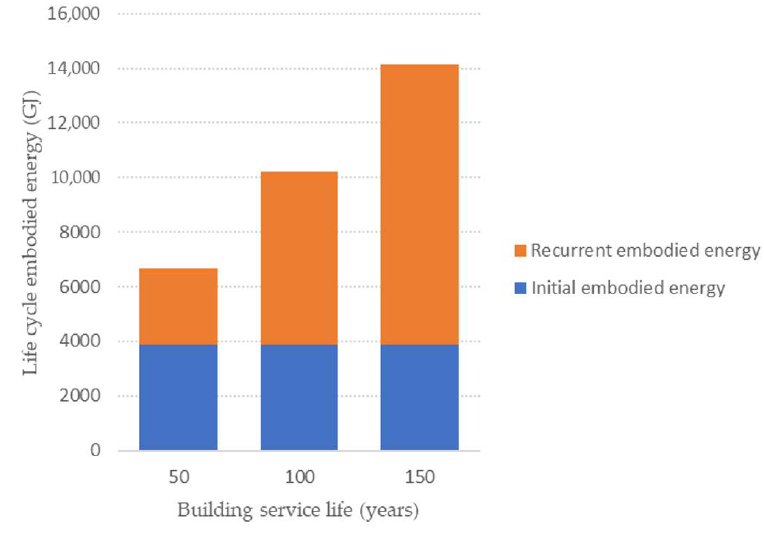
Figure 6. Life cycle embodied energy of the case study house with the average material service life for building service lives of 50, 100 and 150 years.